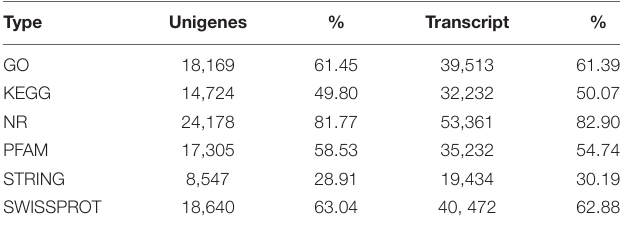
TABLE 4 | Database annotation statistics for unigenes and transcripts.